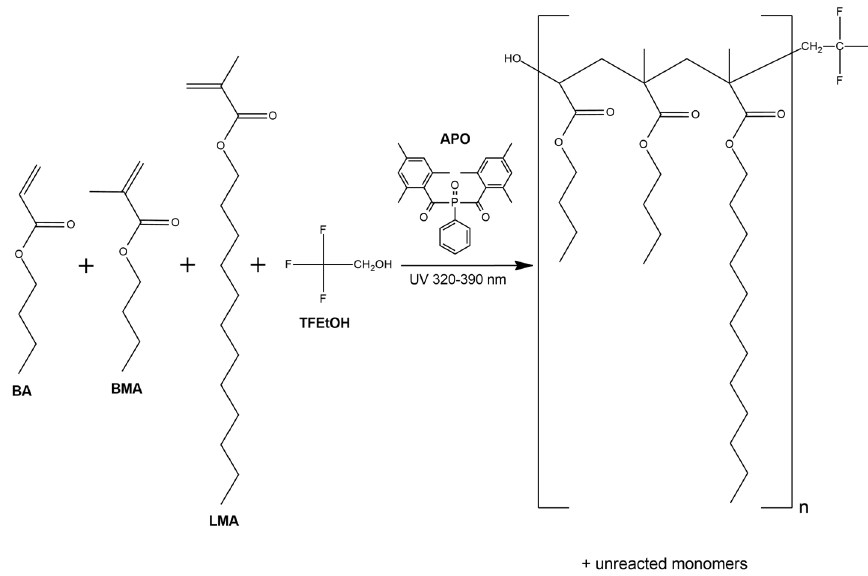
Figure 2. The schematic reaction of the UV-induced telomerization process.